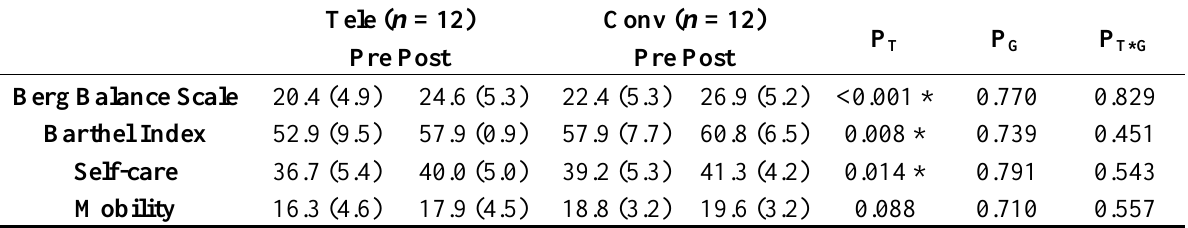
Table 2. Effects of intervention on balance and functional activity in telerehabilitation (Tele) and conventional balance training (Conv)